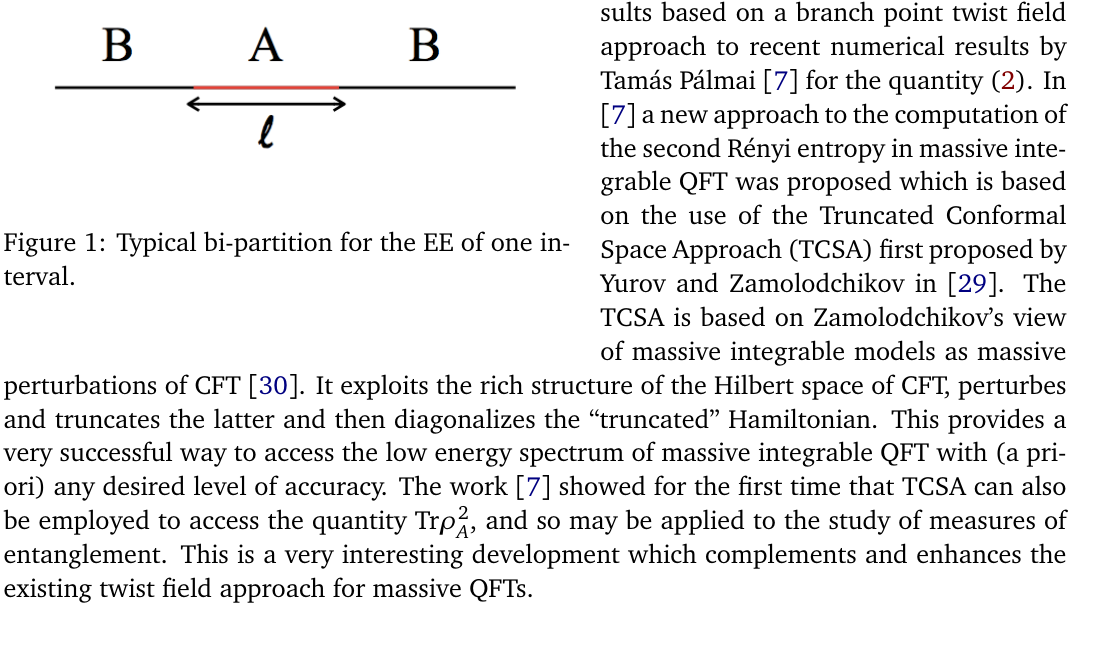
sults based on a branch point twist field approach to recent numerical results by Tamás Pálmai [ 7 ] for the quantity (2). In [ 7 ] a new approach to the computation of the second Rényi entropy in massive inte- grable QFT was proposed which is based on the use of the Truncated Conformal Space Approach (TCSA) first proposed by Yurov and Zamolodchikov in [ 29 ] . The TCSA is based on Zamolodchikov’s view of massive integrable models as